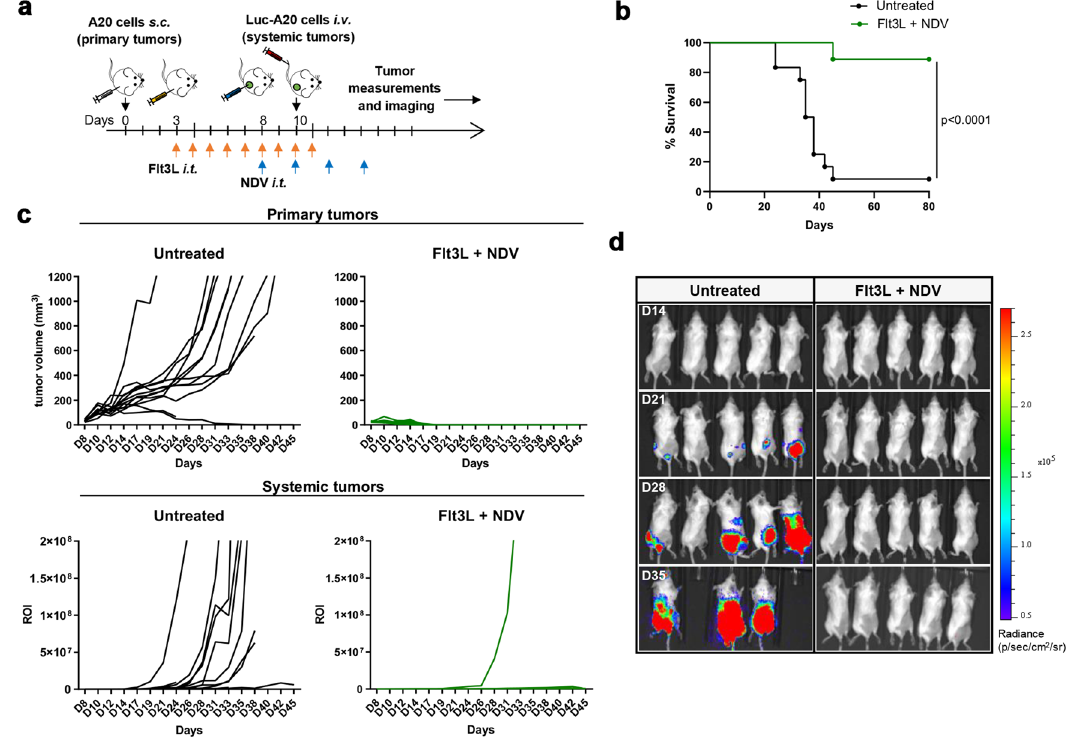
Fig. 4 |Flt3L+NDV combinationtherapy inducesef fi cient systemicanti-tumor immunity. a GFP + A20 tumor-bearing mice were treated as indicated and addi- tionallychallengedwithsystemicluciferase + (Luc)A20tumors.Micewerefollowed forsurvival( b ),primarytumorgrowth( c ,upperpanel)andsystemictumorgrowth